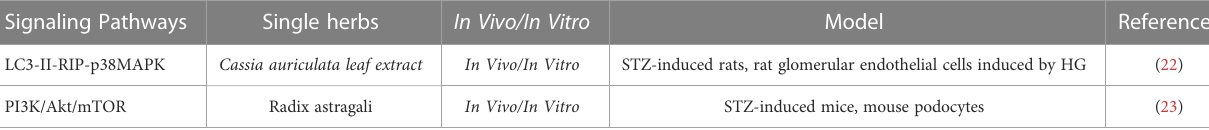
TABLE 2 The role of single herbs against renal injuries via regulating autophagy in DKD. Signaling